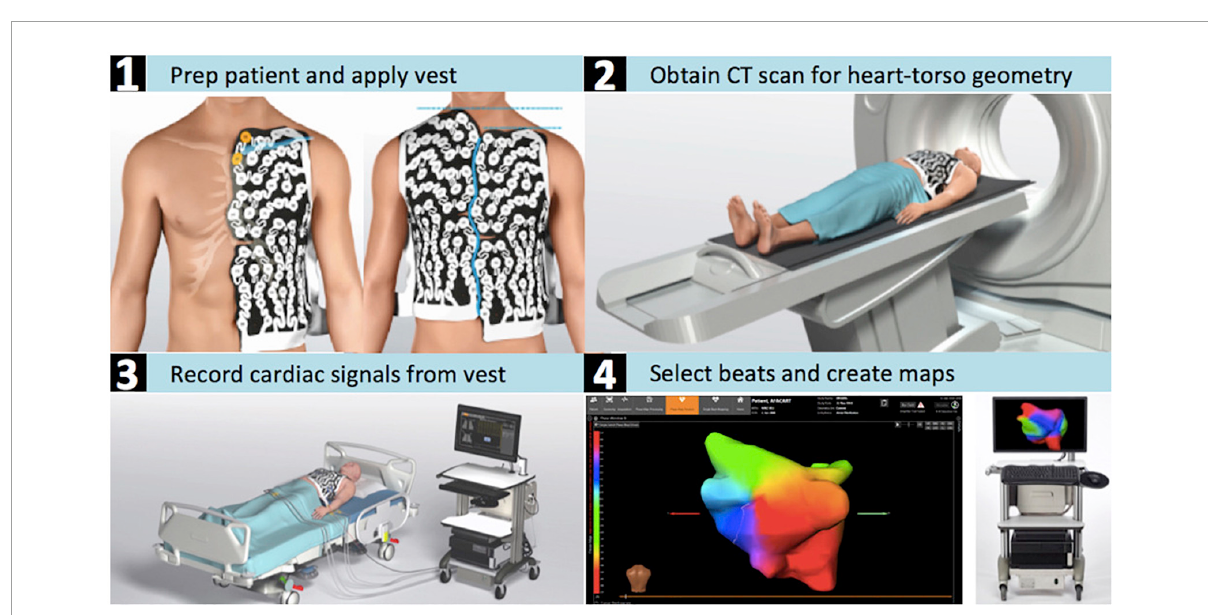
FIGURE2 CardioInsight TM mapping system. Depicted are the steps required for the estimation of the electrical potentials on the atrial epicardial surface with the aid of non-invasive electrocardiographic imaging. (1) The patient is shaved and the ECGI electrode vest is put on the dry skin. (2) The patient’s torso and cardiac geometries are acquired through computed tomography while wearing the vest. (3) Body-surface potentials are recorded with an array of 252 body-surface electrodes. (4) 3D reconstruction of both atria is performed and the atrial surface potentials are reconstructed by the system’s